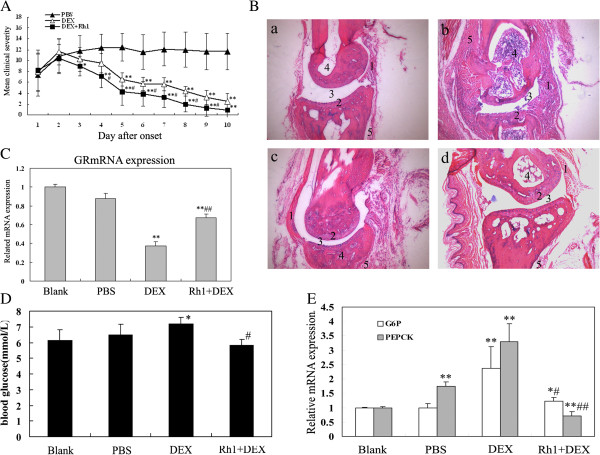
Anti-inflammatory potential of ginsenoside Rh1 combined DEX in CIA. (A) After onset of arthritis, CIA mice were randomized in a PBS, DEX (1 mg/kg) treatment or Rh1 (10 mg/kg) combined with DEX (1 mg/kg) treatment protocol. Disease severity was monitored daily. Dots and bars represent mean ± SEM. *P <0.05, **P <0.01 compared with PBS, # P <0.05 compared with DEX. (B) Histopathology of paw joints 10 days post-arthritis onset. HE staining of the metacarpophalangeal joint: a, b, c and d are representative images for blank (normal mice), PBS-, DEX- and Rh1 combined with DEX-treated mice, respectively. The different parameters assessed are 1) influx of inflammatory cells in joint capsule, 2) cartilage destruction, 3) joint cavity narrowing, 4) influx of inflammatory cells in marrow cavities, and 5) and periosteal thickening. (C) Real time PCR was performed in parallel on liver tissues extracts with GR primers. Gene expression of the housekeeping gene GAPDH was used for normalization. *P <0.05, **P <0.01 compared with blank, ##P <0.01 compared with DEX. (D) The blood glucose concentration was determined 6 h after treatment (mice were fasted 18 h before the blood samples were taken). The normal mice were as blank. Values are expressed as means ± SD. *P <0.01 versus blank??; #P <0.01 versus DEX group. (E) Liver samples were taken from the CIA mice after 10 days of treatment. PCR analysis with primers detects the household gene β-actin (loading control) or the gene coding for PEPCK and G6P in the same sample. *P <0.05, **P <0.01 compared with blank, #P <0.05, ##P <0.01 compared with DEX. CIA, collagen-induced arthritis; DEX, dexamethasone; G6P, glucose-6-phosphatase; GR, glucocorticoid receptor; PBS, phosphate-buffered saline; PEPCK, phosphoenolpyruvate carboxykinasee phosphatase.